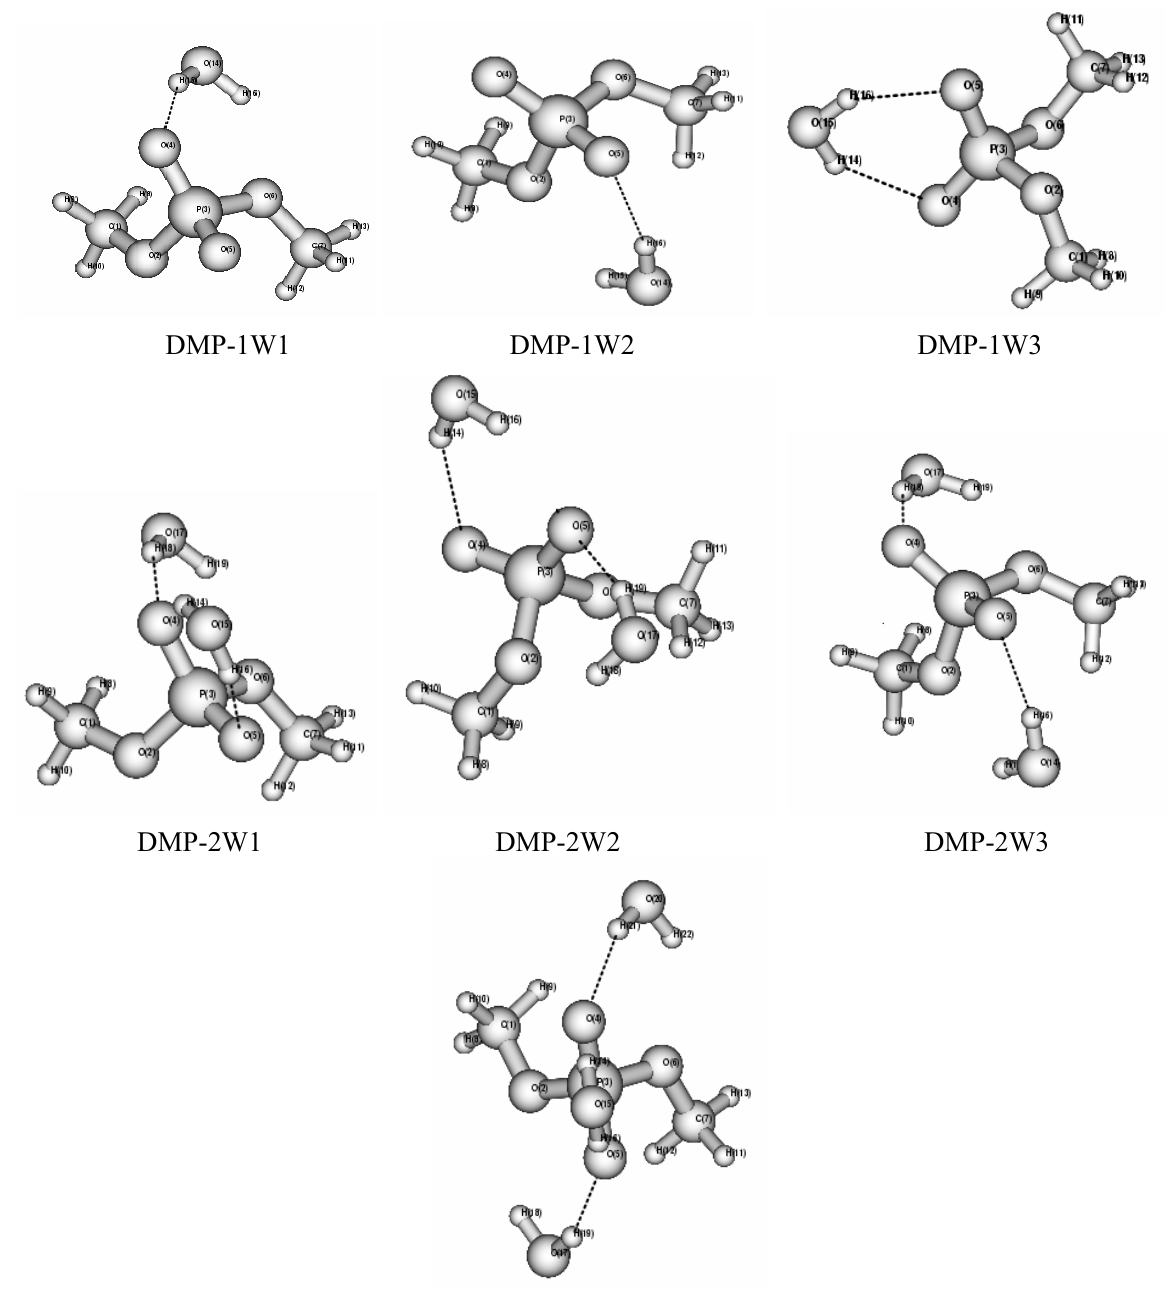
Figure 2. Structures of the DMP anions interacting with one, two, and three water molecules.